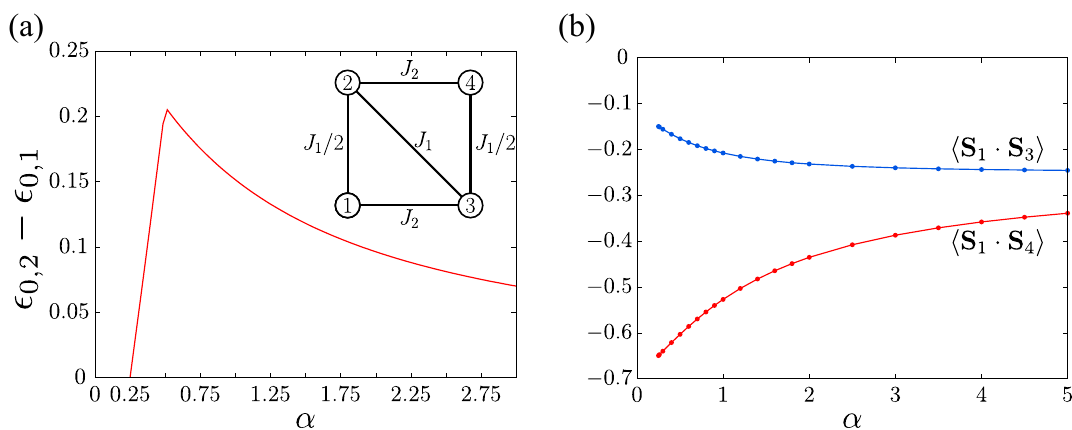
) to S tot = 2 ( ε ) sectors in 0,1 0,2